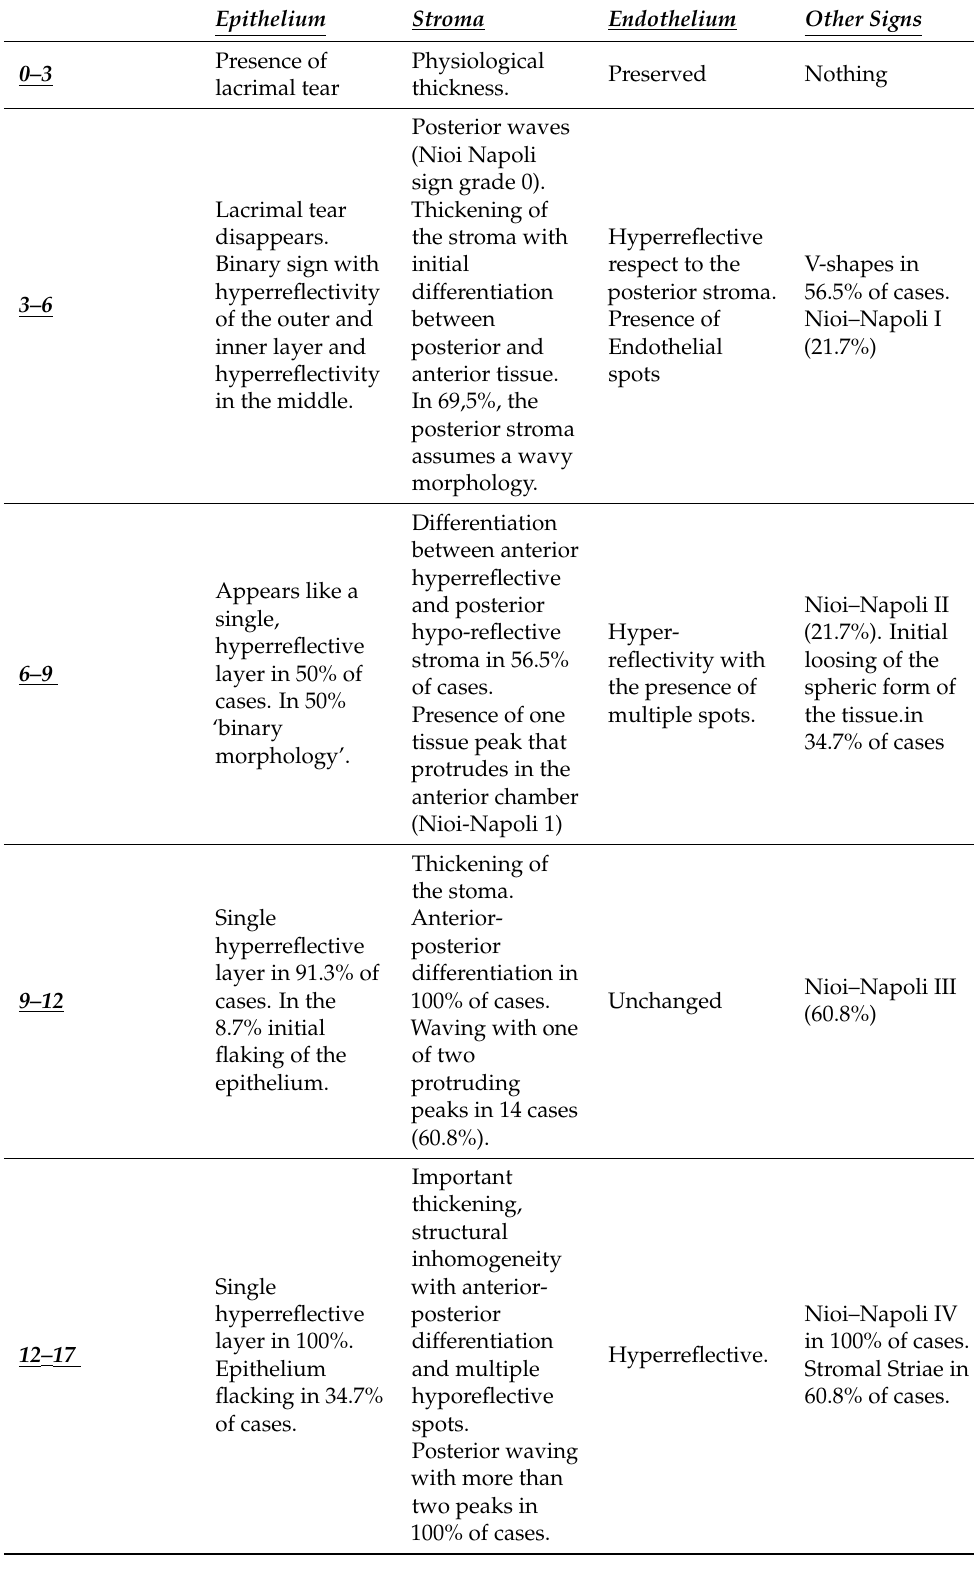
Table 2. Main changes in the closed eyes in interval postmortem from 0 to 17